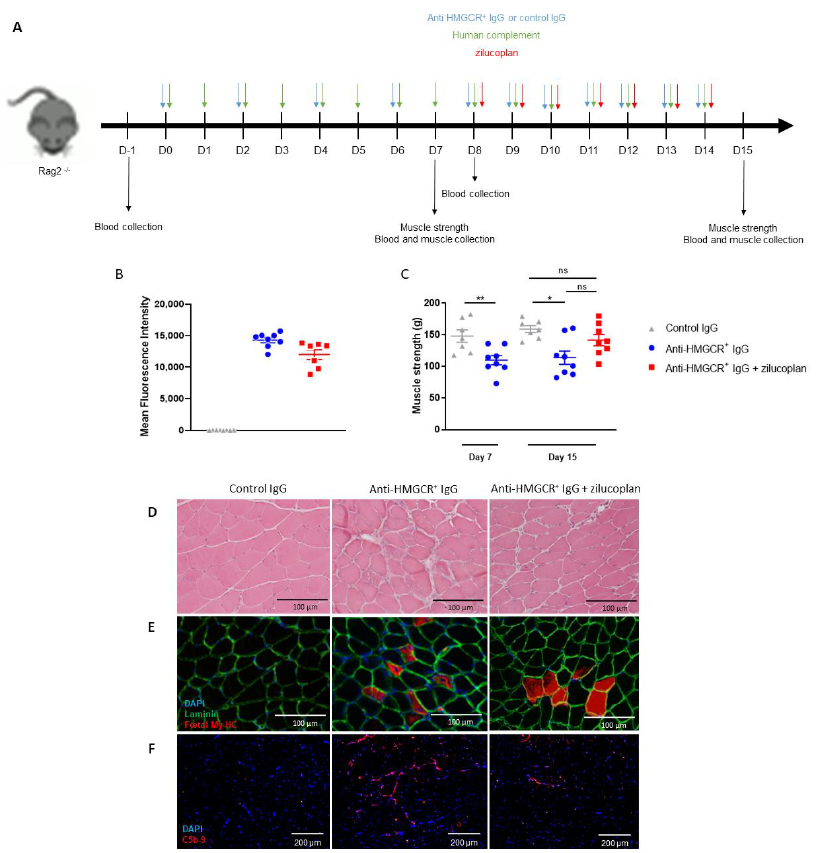
Figure 3. C5 inhibition partially ameliorates IMNM in Rag2 − / − mice supplemented with human complement. ( A ) Rag2 − / − mice (n = 8/group) received injections of purified IgG from a patient suffering from anti-HMGCR + IMNM or purified IgG from normal serum in conjunction with human complement. Two groups were sacrificed at day 7 for assessing muscle strength. Moreover, three groups of Rag2 − / − mice received injections of IgG purified from normal serum or from a patient suffering from anti-HMGCR + IMNM with or without zilucoplan daily from day 8 in conjunction with human complement and were sacrificed at day 15. ( B ) Circulating levels of anti-HMGCR aAb by addressable laser beads immunoassay (ALBIA) in the serum of mice at day 15. ( C ) Muscle strength was evaluated by measurement of gastrocnemius contraction upon electrostimulation (muscle strength). ( D ) H & E staining. Scale bar = 100µm. ( E ) Immunodetection of regenerative myofibres after staining with mouse anti-foetal myosin heavy chain (My-HC) antibody followed by Alexa 647-labeled anti-mouse IgG antibody (red). Muscle fibres are made visible using rabbit anti-laminin antibody followed by Alexa 488-labeled anti-rabbit IgG (green) and DAPI (blue) for staining nuclei. Scale bar = 100 µm. ( F ) Complement deposits (red) on the surface of myofibres after staining with rabbit anti-C5b-9 antibody followed by Alexa 647-labeled anti-rabbit IgG and DAPI counterstaining (blue). Scale bar = 200µm. Data are presented as mean ± SD; ns is for non-significant * p < 0.05, ** p < 0.01, *** p < 0.001 by Mann – Whitney two-tailed test. One out of two reproducible experiments is shown.